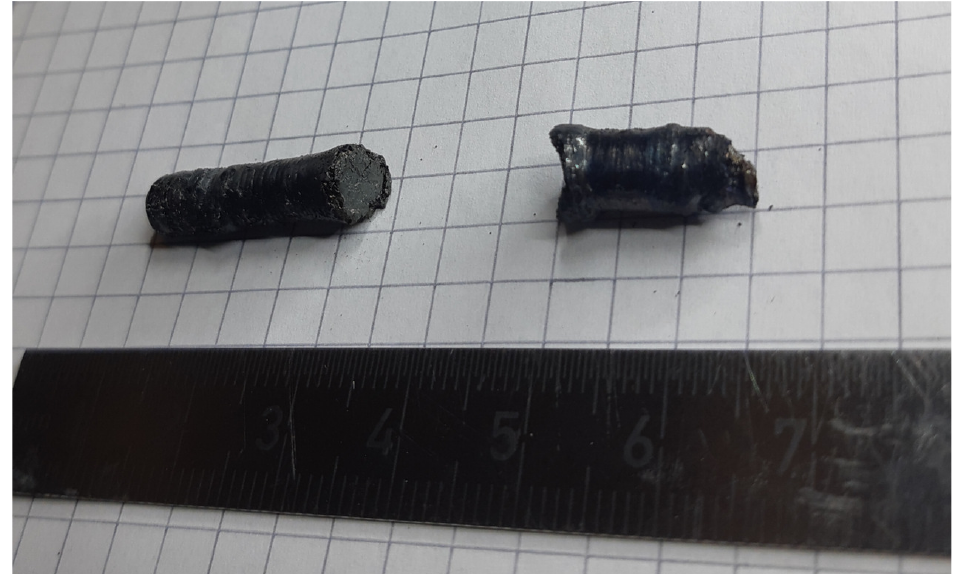
Figure 1. Photo of the as-grown Ba 26 Ru 12 O 57 single crystal in the left (with a ruler below that is showing large ticks in units of 1